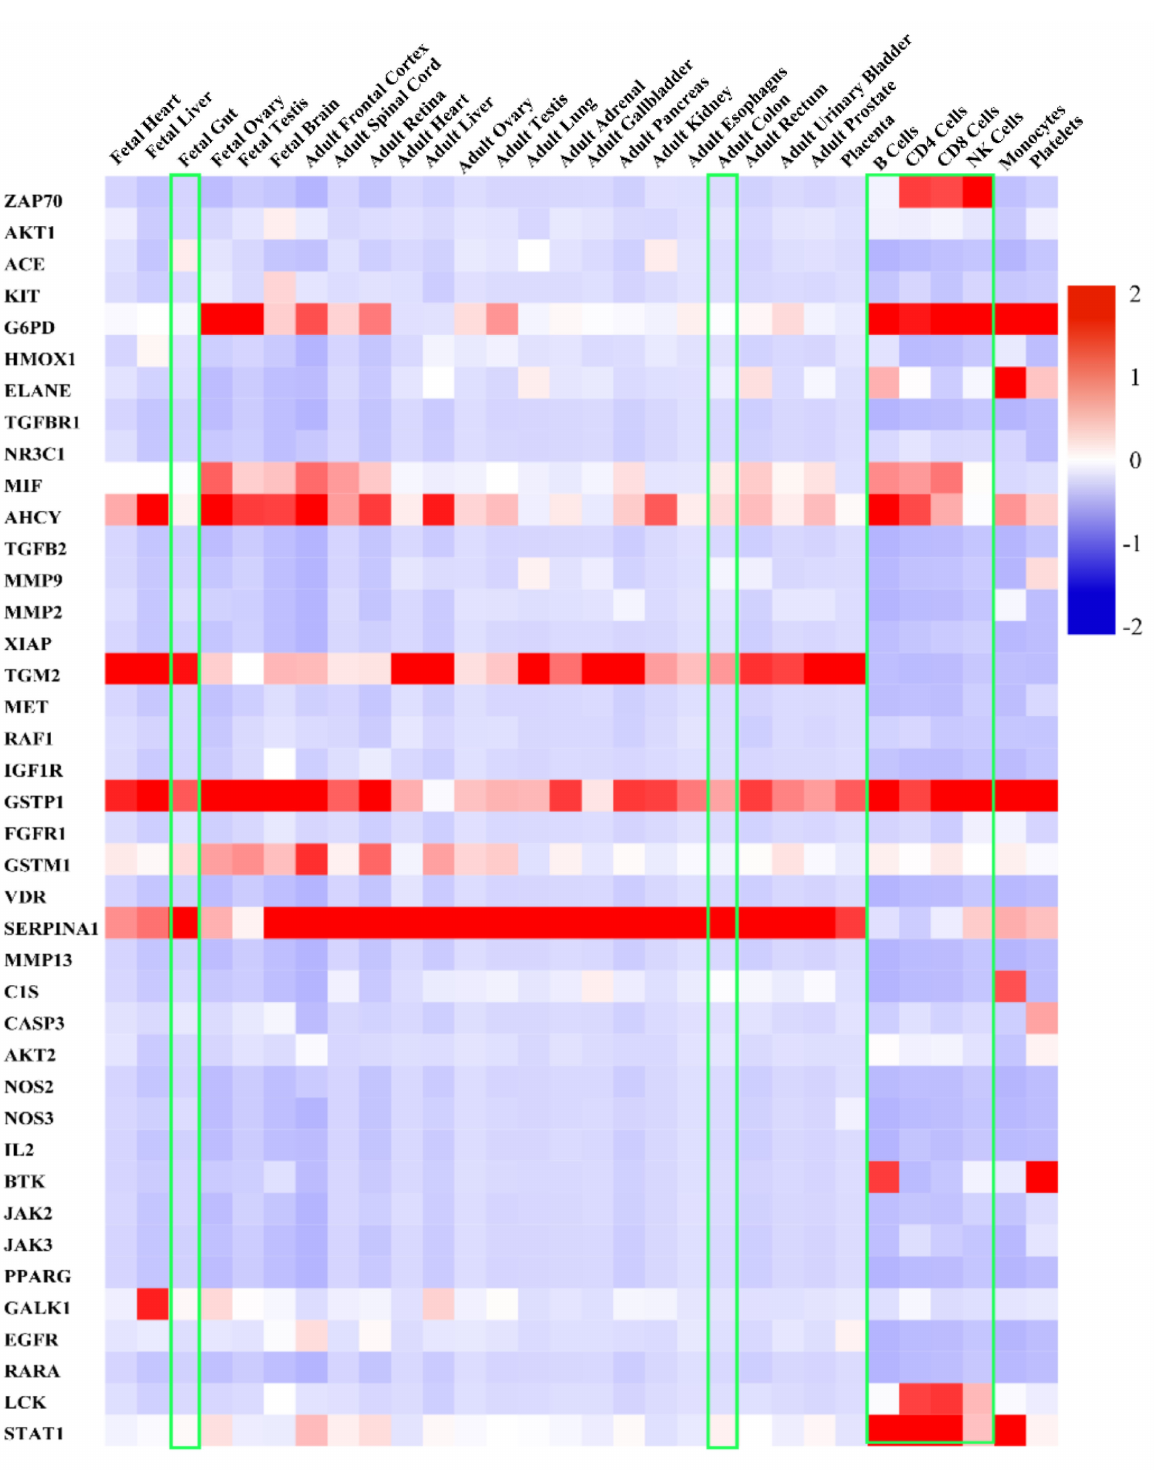
Figure 4. Analysis of the expression of the selected hub targets in the organs based on FunRich software (Ver. 3.1.3). Horizontal coordinates represent organs, while the ordinate coordinates express the hub targets. And the red color represents the high expression of the hub targets in organs, and blue represents the low expression. The green box represents the hub targets involved in the key organs which related to